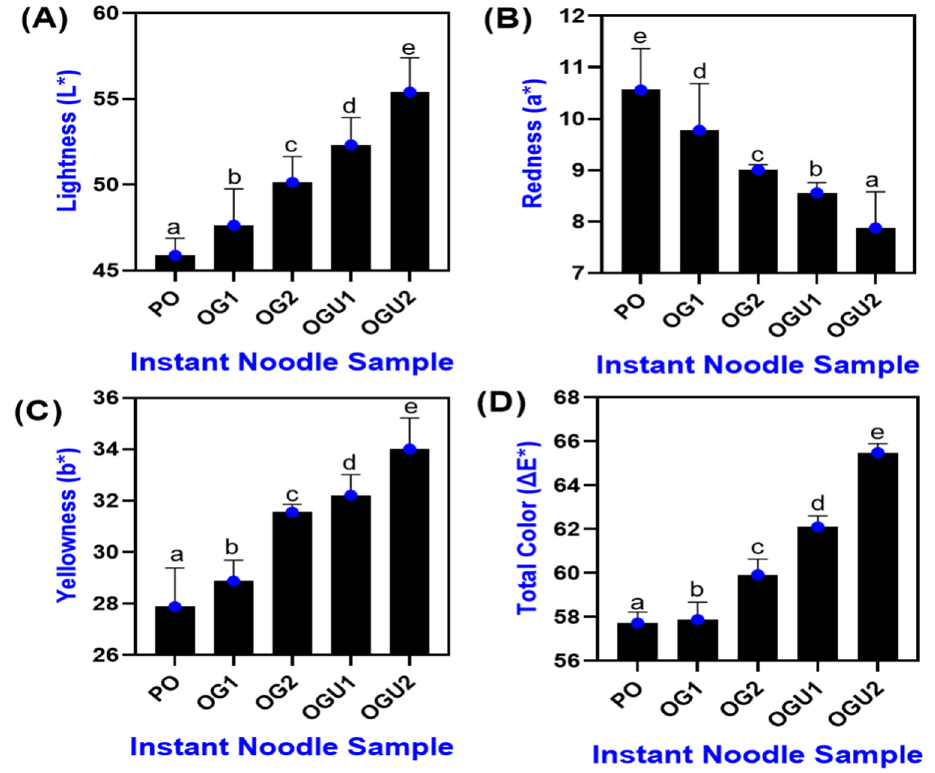
Figure 1. Color characteristics (L* ( A ), a* ( B ), b* ( C ) and ∆ E* ( D )) of palm oil, palm oil–carnauba wax oleogel and palm oil–carnauba wax oleogel with ultrasonication treatments. Note: PO represents palm oil; OG1 represents palm oil–carnauba wax (5 g/100 g); OG2 represents palm oil–carnauba wax (10 g/100 g); OGU1 represents palm oil–carnauba wax (5 g/100 g) homogenized with ultrasonication; and OGU2 represents palm oil–carnauba wax (10 g/100 g) homogenized with ultrasonication. The different alphabets (a–e) in the figures indicate significant differences.